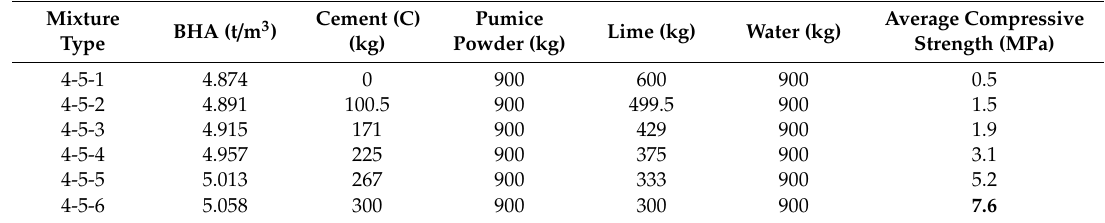
Table 29. Type-4-5 mixture quantity, weight per unit of volume and compression test results.